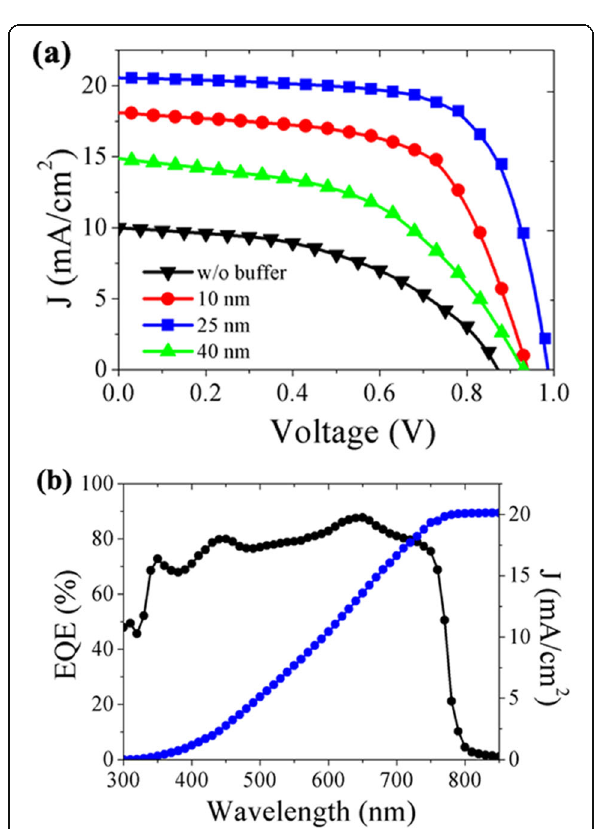
Fig. 3 Photovoltaic performance of solar cells w/o and with CdSe QD layers with different thickness ( a ). External quantum efficiency and the integrated current density of the optimized solar cell ( b